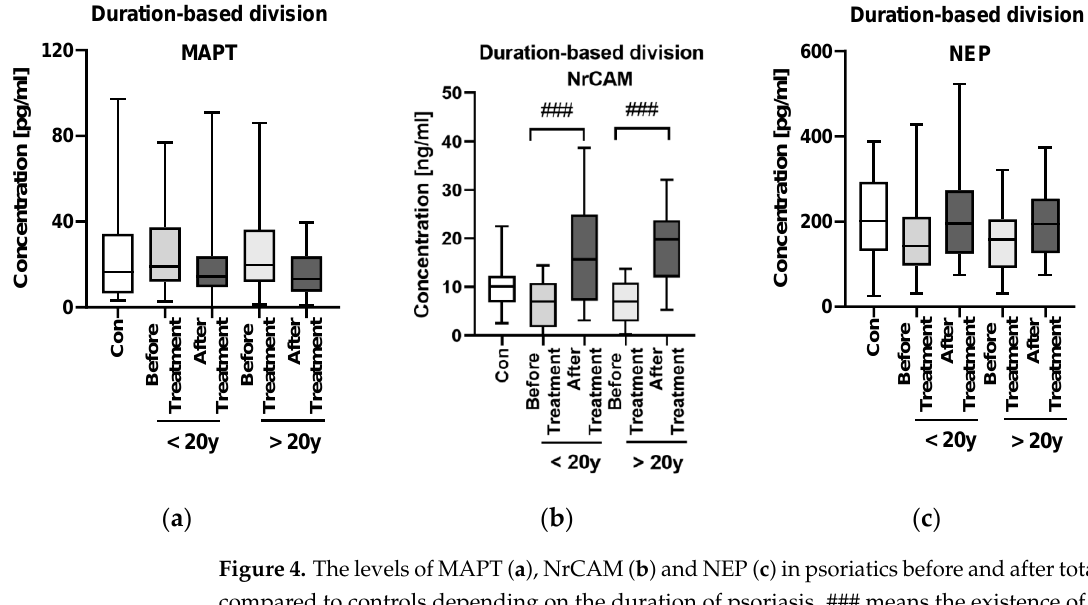
Figure 4. The levels of MAPT ( a ), NrCAM ( b ) and NEP ( c ) in psoriatics before and after total treatment compared to controls depending on the duration of psoriasis. ### means the existence of statistically significant difference between patients before and after the treatment with p < 0.001. After twelve weeks of systemic therapy a significant clinical improvement reflected inter alia by PASI decrease was observed ( p < 0.001). The median MAPT serum level decreased significantly to 13.16 pg/mL after the therapy ( p < 0.01), approaching the